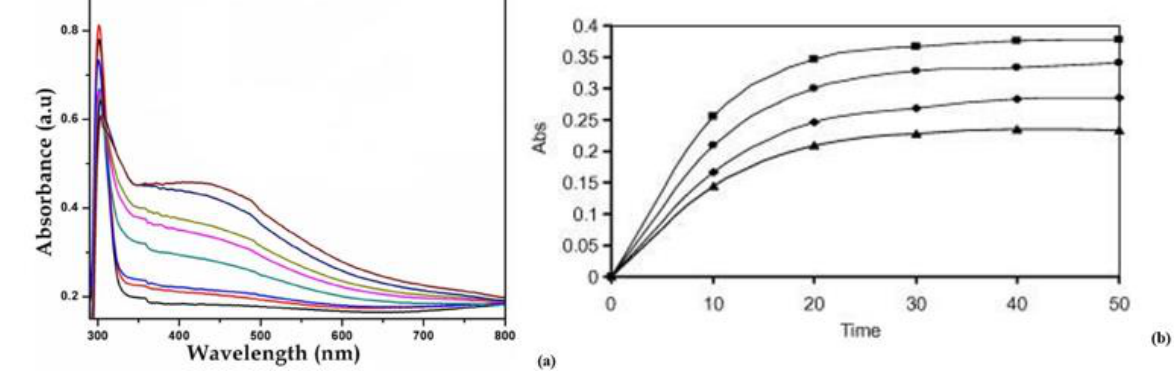
(a) Absorption spectrum of CdO nanoparticles–phenyl mercaptan during 0–1200 (s) (b) Absorption curve against time for CdO nanoparticles–phenyl mercaptan at maximum wavelength